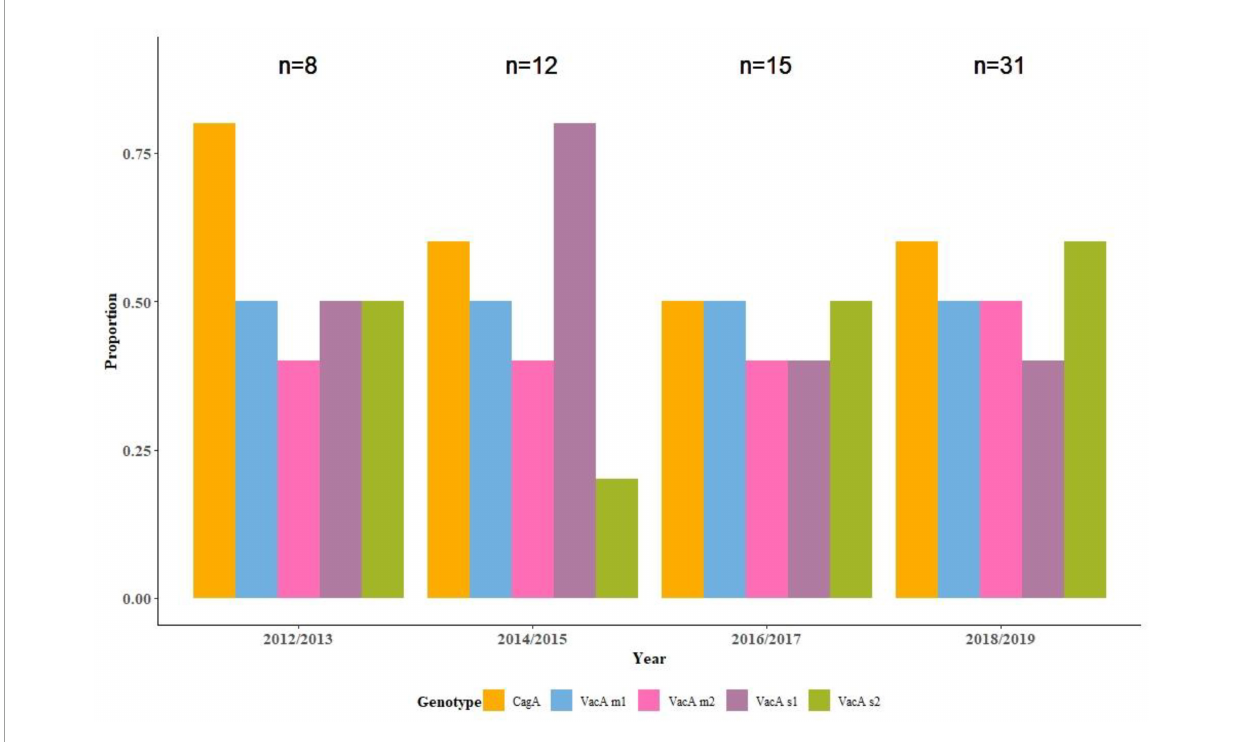
FIGURE2 Trends in the distribution of Helicobacter pylori genotypes ( CagA , VacA s1 , VacA s2 , VacA m1 , and VacA m2 ) from 2012 to